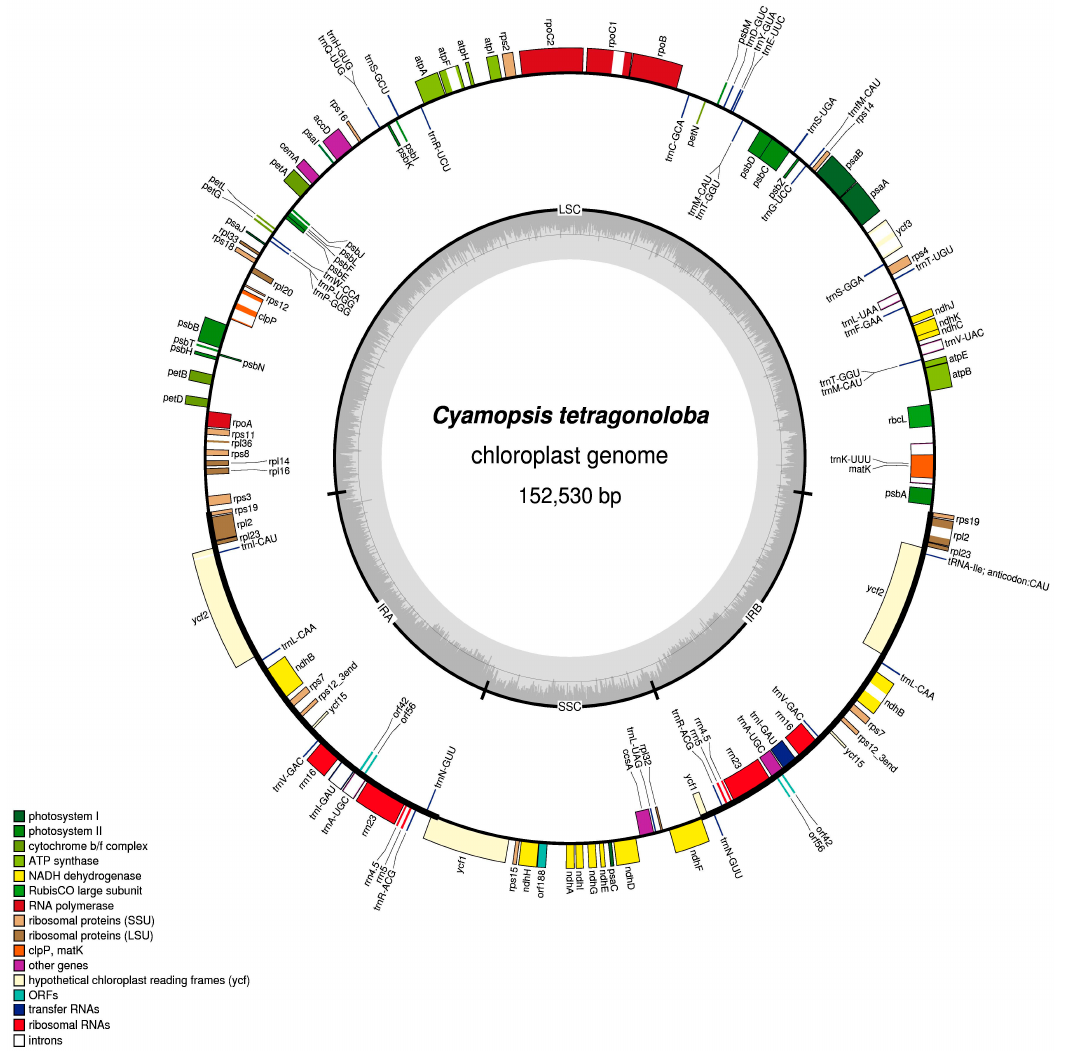
Figure 1. Map of Cyamopsis tetragonoloba plastid genome. Genes shown on the outside of the map are transcribed clockwise, while the genes that are shown on the inside are transcribed counterclockwise. The innermost darker gray corresponds to GC content, whereas the lighter gray corresponds to AT content. Different genes are colour coded. IR: inverted repeat; LSC: large single copy region; SSC: small single copy region. Table 1. Features of the chloroplast genome of Cyamopsis tetragonoloba . T: Thymine; U: Uridine; C; Cytosine; A: Adenine; G: Guanosine; IRa: Inverted Repeat a; IRb: Inverted Repeat b.